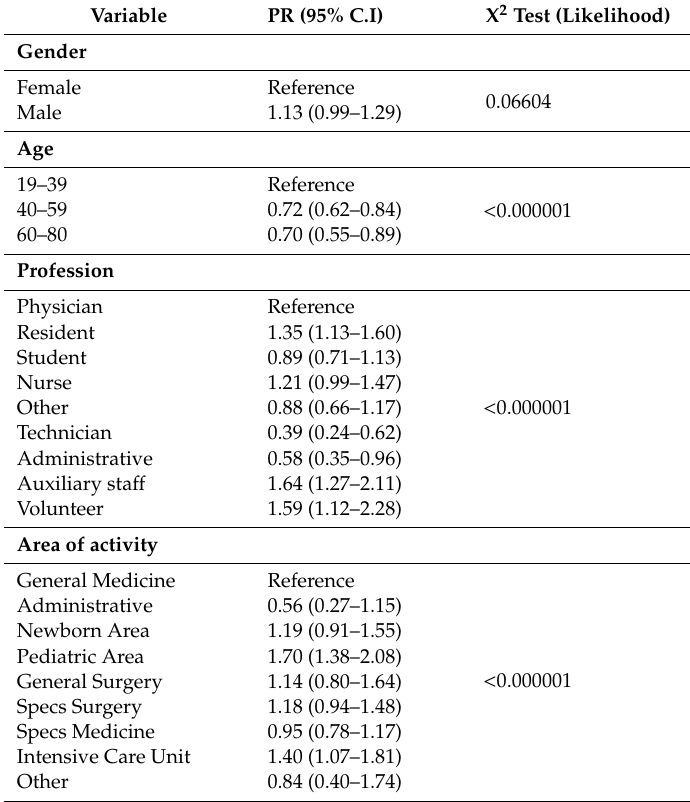
Table 3. Prevalence ratios of onsite ambulatory versus ad hoc ambulatory (year 2019).